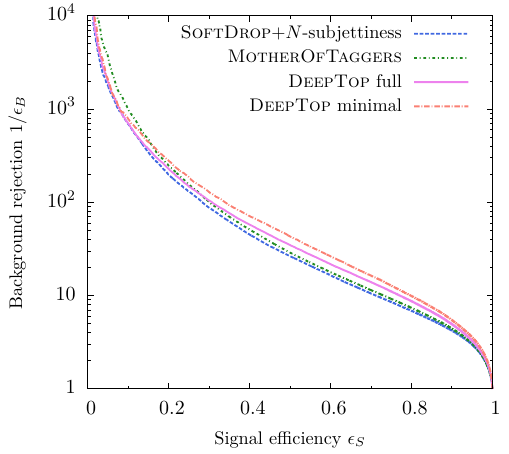
Figure 8 . Performance of the neural network tagger compared to the QCD-based approaches SoftDrop plus N -subjettiness and including the HEPTopTagger